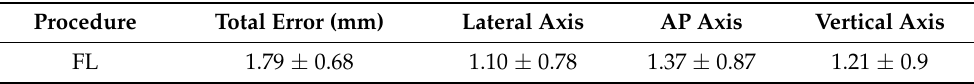
Table 1. Accuracy of the Frameless Fiducial-less